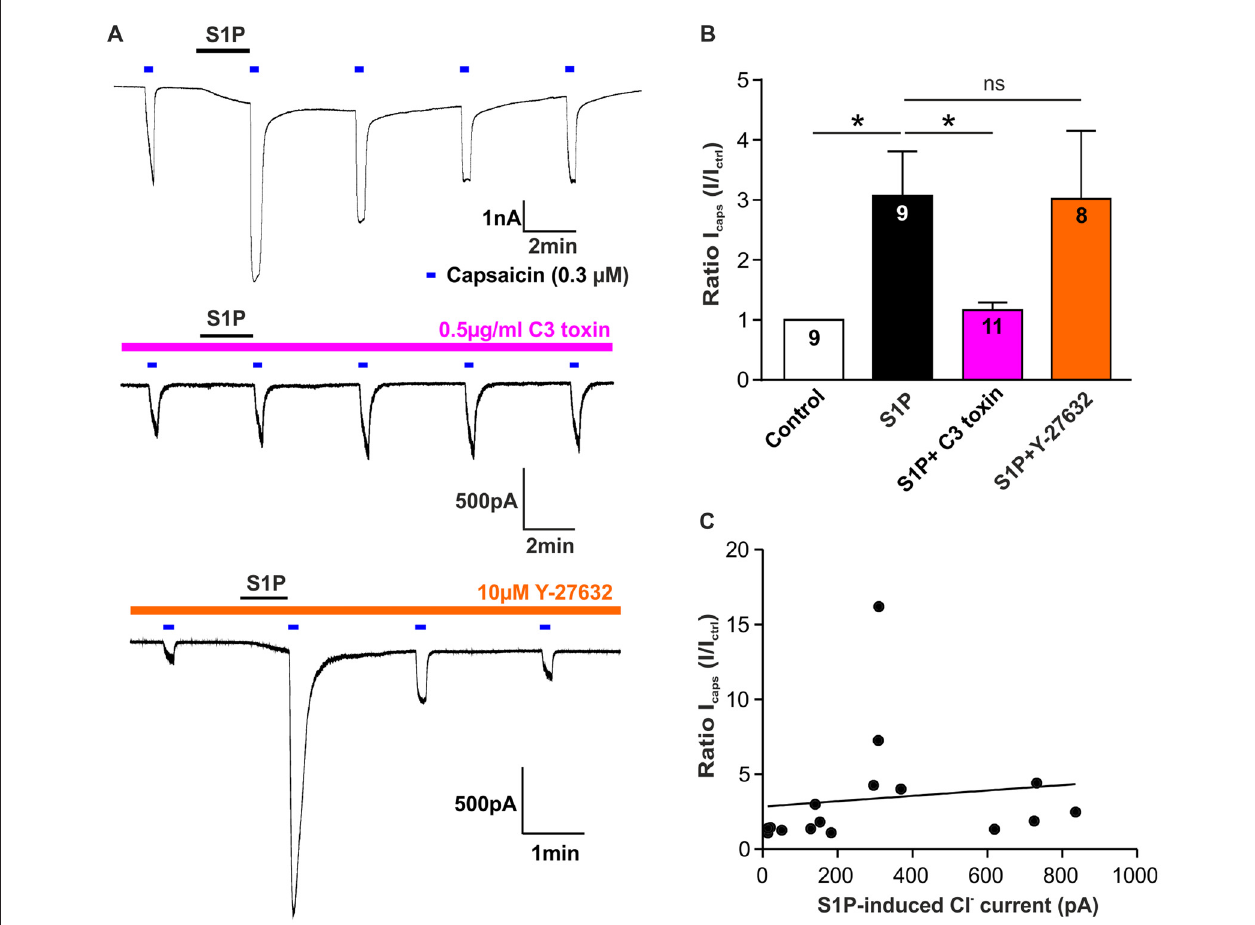
FIGURE 5 | Rho but not ROCK is involved in S1P-induced I caps potentiation in sensory neurons. (A) Typical voltage-clamp recording of current stimulated repetitively with capsaicin (0.3 µ M) in DRG neurons treated without or with Rho inhibitor C3 toxin (0.5 µ g/ml) or ROCK inhibitor Y-27632 (10 µ M) at − 60 mV holding potential. 1 µ M S1P was applied between capsaicin stimulation. (B) Quantification of S1P-induced I caps potentiation, which was normalized to the control I caps peak amplitude (I ctrl: I caps before S1P application), in DRG neurons treated without or with C3 toxin or Y-27632. Exposure to S1P (1 µ M, 1 min) significantly increased I caps in DRG neurons (Unpaired t -test, control vs. S1P, ∗ p < 0.05). C3 toxin (0.5 µ g/ml, overnight) treatment significantly reduced S1P-induced potentiation of I caps in DRG neurons (Unpaired t -test, S1P vs. S1P+C3 toxin, ∗ p < 0.05). Y-27632 pretreatment (10 µ M, 30 min) did not affect S1P-induced potentiation of I caps in DRG neurons (Unpaired t -test, S1P vs. S1P+Y27632, p > 0.05). The number of recorded cells was noted in the bar. (C) Pearson correlation scatter plots showing that there was no linear correlation between S1P-induced Cl − current and S1P-induced potentiation of I caps ( n = 16, p = 0.6293, r 2 = 0.0171). I S1P and I caps were recorded on the same neuron.